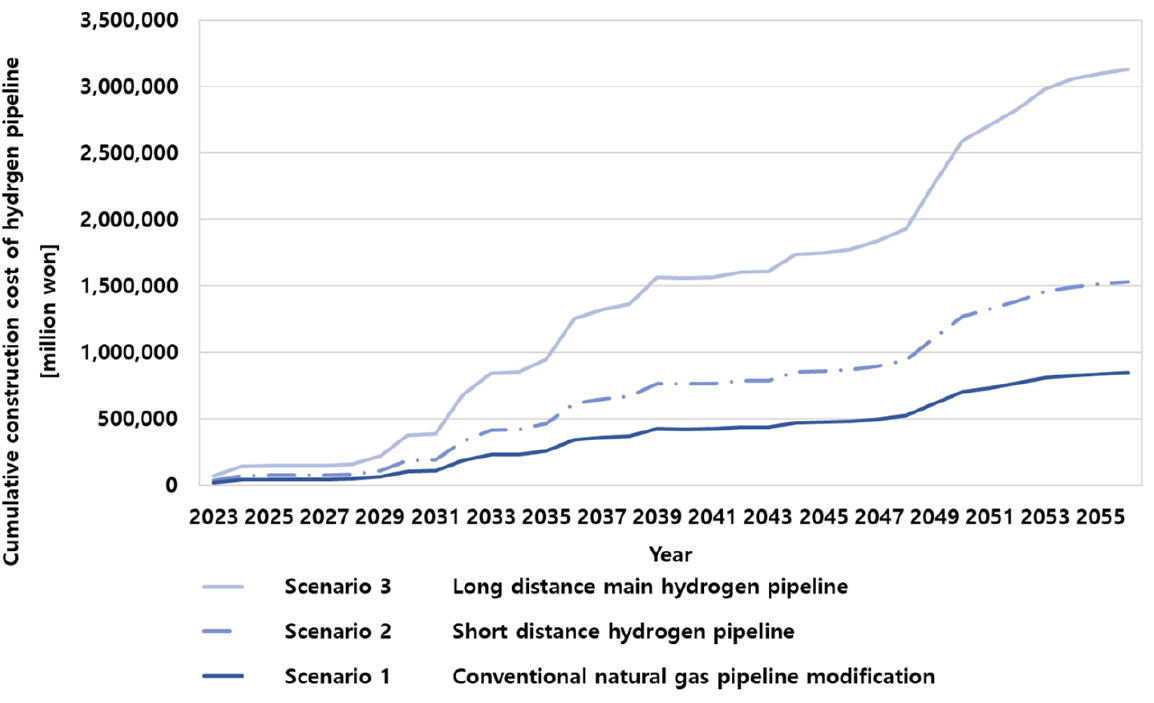
Figure 2. Accumulative construction cost of hydrogen pipelines by year based on case scenarios.